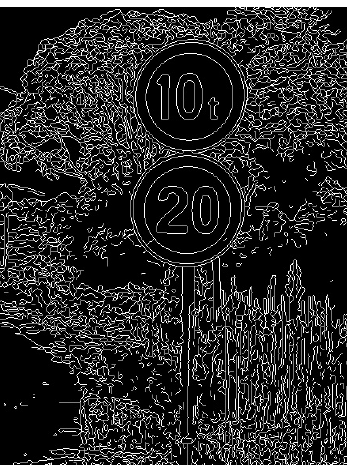
Figure 4: The Result Calculated by EDarwing